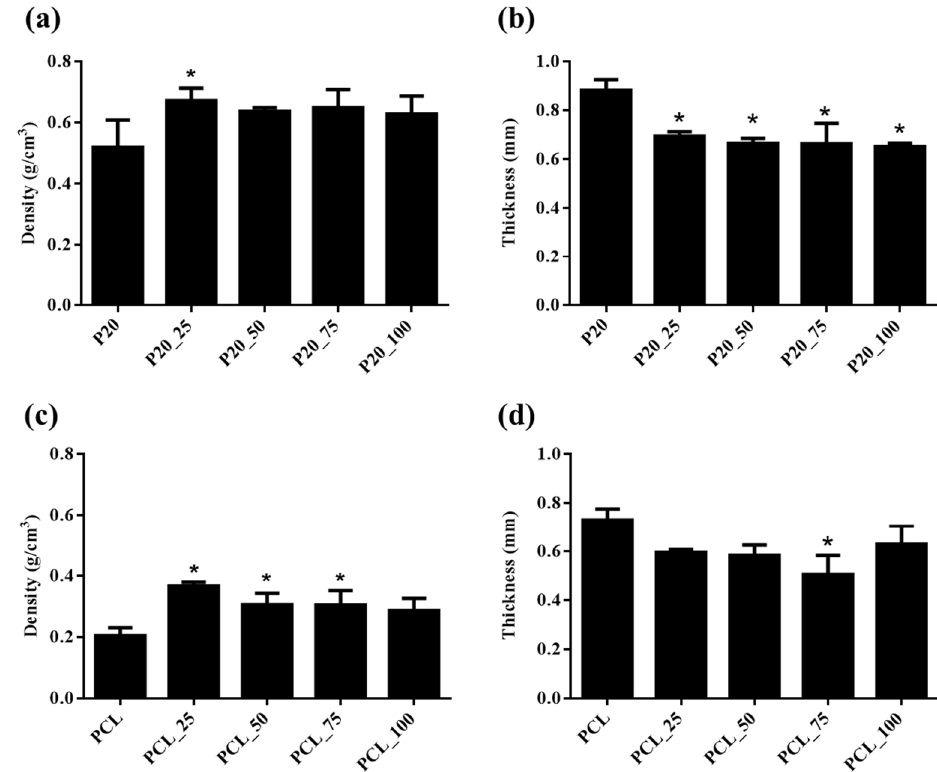
Figure 2. Influence of cefazolin concentration in the ORC/PCL bilayered composite and PCL on density and thickness of fabricated samples: ( a ) Density of cefazolin loaded ORC/PCL bilayered composite; ( b ) thickness of cefazolin loaded ORC/PCL bilayered composite; ( c ) density of cefazolin loaded PCL; ( d ) thickness of cefazolin loaded PCL. Data are expressed as mean ± standard deviation (SD). Significance between cefazolin loaded samples versus control (P20 or PCL) is indicated as * ( p < 0.05).